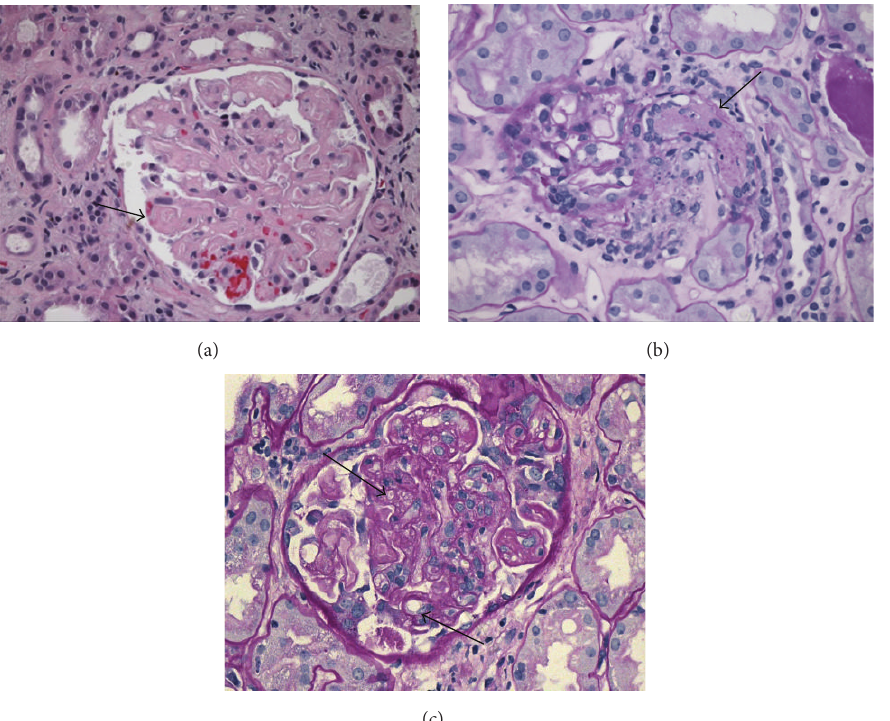
Figure 1: Light micrographs showing TMA. (a) Patient 1: H&E 20x: glomerulus with consolidated appearance caused by swelling of endothelial cells (endotheliosis). (b) Patient 2: PAS, 20x: glomerulus with an arteriole occluded by a thrombus. (c) Patient 3: PAS, 40x: mesangiolysis and double